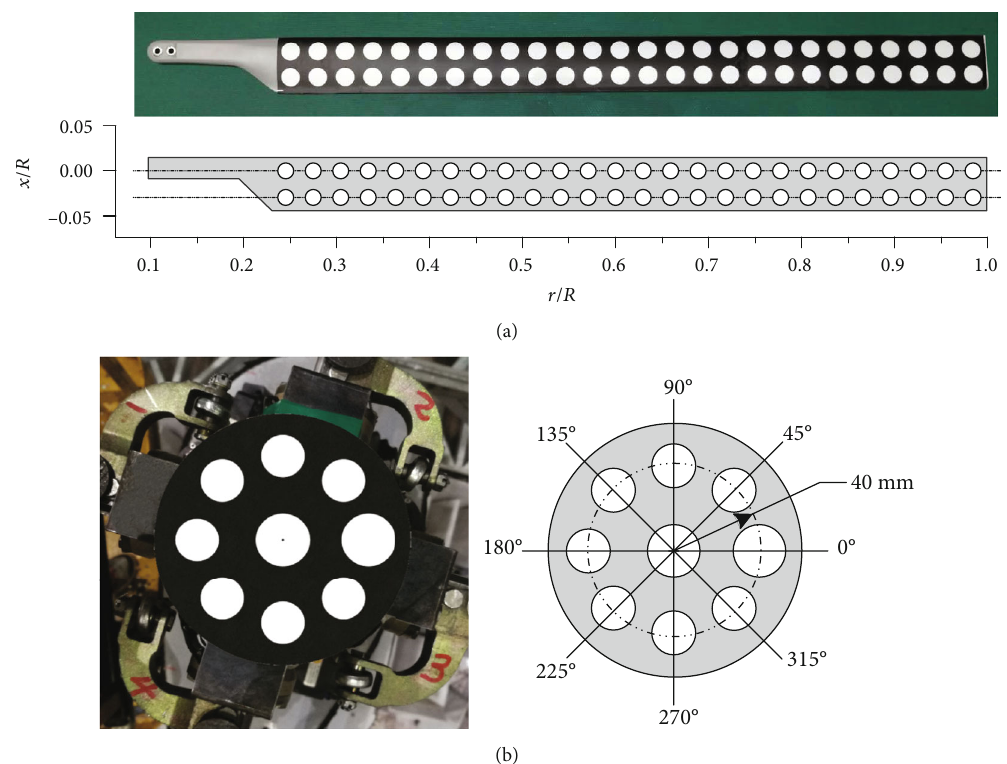
Figure 4: Distribution of (a) blade retrore fl ective targets and (b) hub retrore fl ective